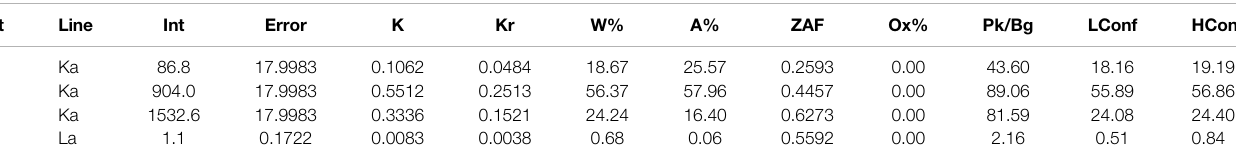
TABLE 1 | EDX elemental analysis of Y-MOF synthesized under optimal condition of microwave route.